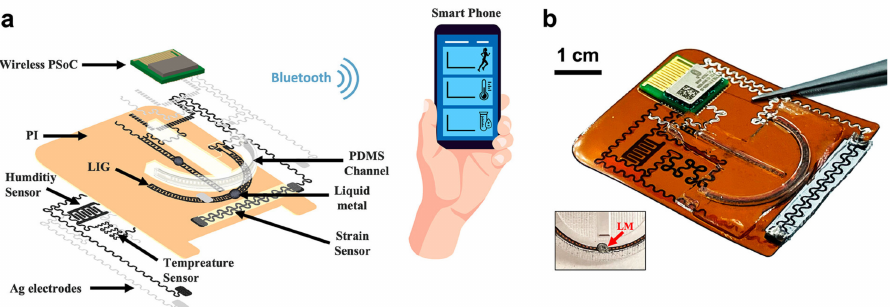
Figure 9. The LIG and liquid metal integrated multifunctional wearable system. ( a ) Conceptual illustration of the multifunctional wireless platform showing an exploded view of the different layers composing the platform containing the inertial, temperature, humidity, and breathing sensors. ( b ) Optical photograph of the fabricated multifunctional platform; the inset shows the LM placed inside the curved patterned PDMS channel. Reproduced with permission from [12]. Copyright 2022 American Chemical